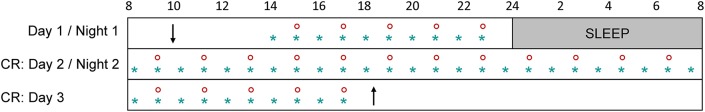
Overview of the experimental protocol. After a habituation day (day 1) and an 8-h sleep episode, participants underwent a 34-h constant routine (CR: days 2 and 3). Subjective sleepiness was measured every hour (blue star) and pupil size was recorded every 2 h (red circle). Participants arrived around 10:00 on day 1 (down arrow) and left the protocol around 18:00 on day 3 (up arrow).